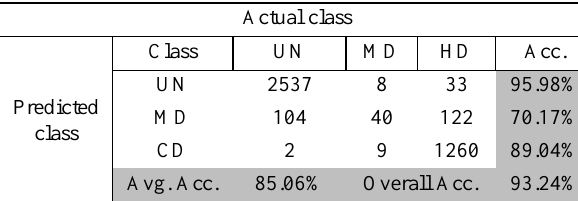
Figure 8. The performance of the two methods in detection of MD areas a) FLS b) SVM